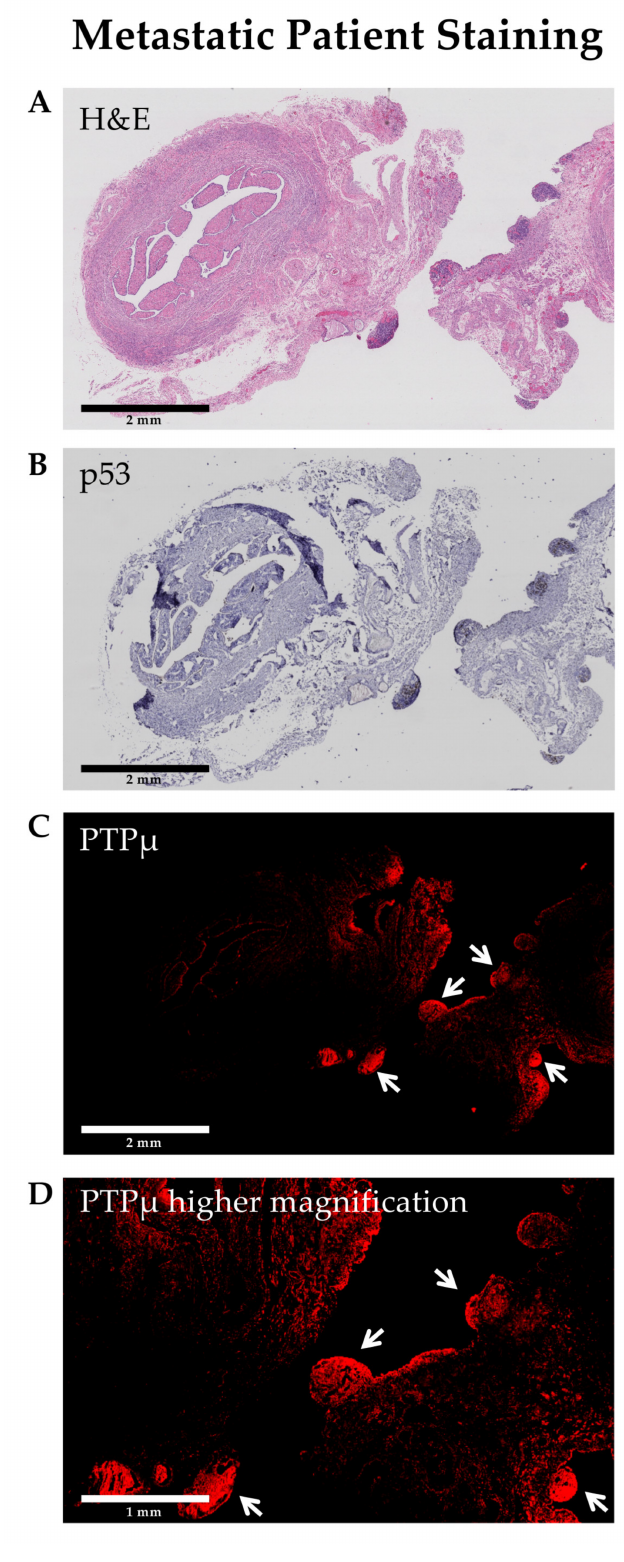
Figure 5. Invasive and metastatic high grade serous ovarian cancer nodules (arrows) are positive for both p53 and the PTP µ biomarker. Staining of adjacent tissue sections for hematoxylin and eosin ( A ), p53 ( B ), and SBK4-TR ( C ) demonstrates that areas of tumor growth are labeled by both p53 antibodies (mutated pattern) and SBK4-TR. Scale bars = 2 mm. A higher magnification image from a region in panel ( C ) is shown in panel ( D ). Scale bar = 1